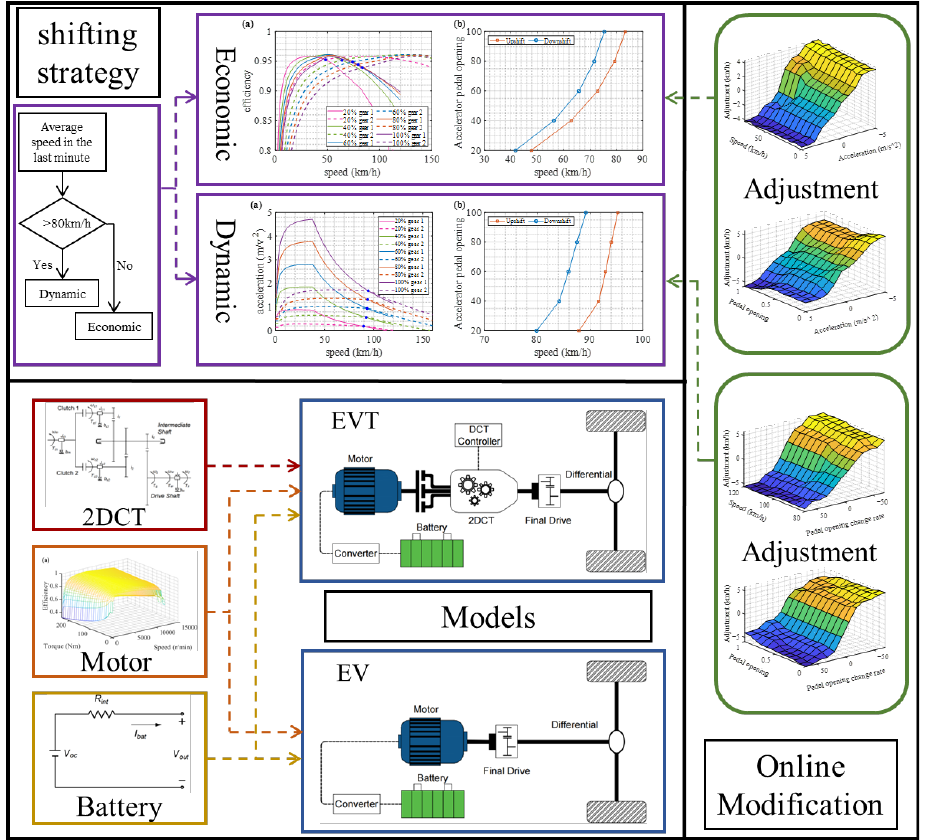
Figure 12. Control system framework.